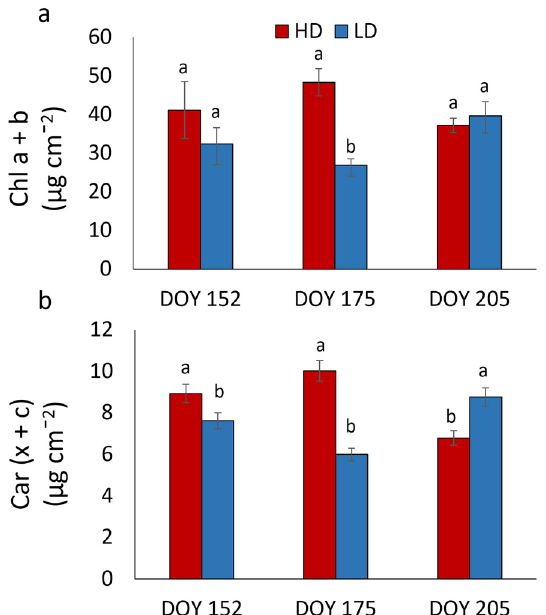
Figure 4. Concentration of total chlorophyll ( a ) and total carotenoids ( b ) in R. pseudoacacia HD and LD plants at DOY 152, 175, and 205. Mean values and standard errors are shown. Different letters correspond to statistically significant differences ( p < 0.05) within the date of